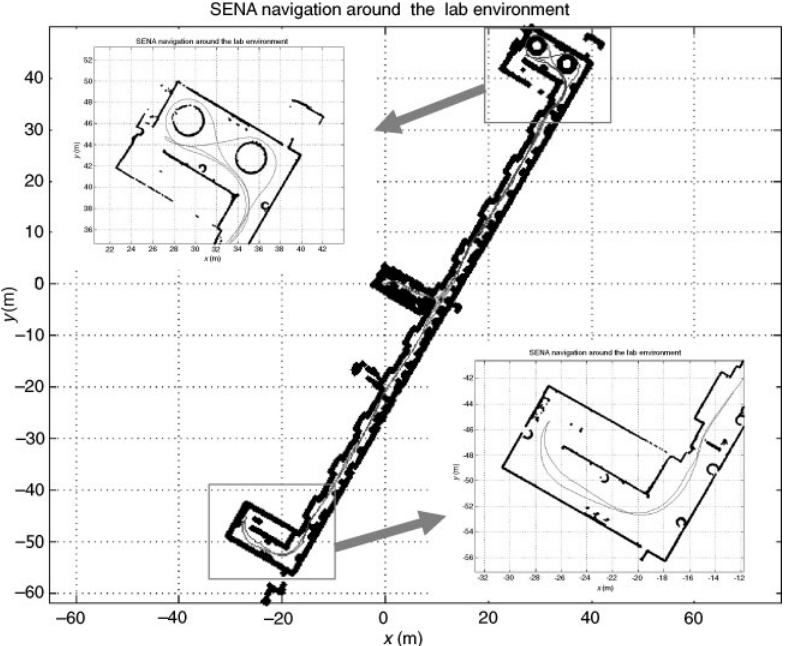
Figure 5 An example of SENA navigation in the surroundings of our laboratory. Rooms and corridors are depicted in thick lines, whereas the path followed by SENA is shown in thin lines. For illustrating the variety and difficulty of the paths performed by SENA in this environment, two interesting zones have been